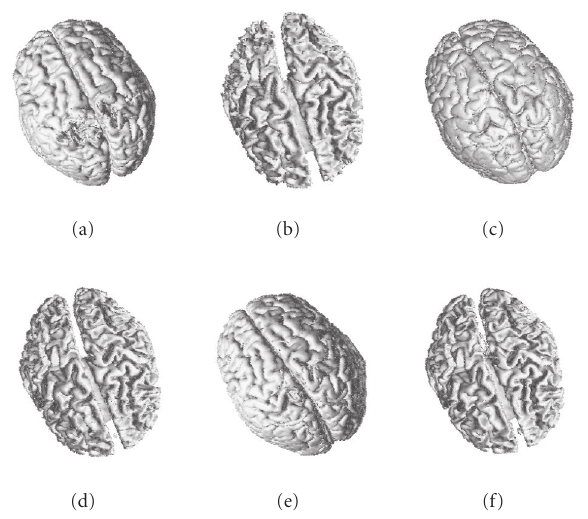
Figure 9: Comparison of the 3D models of GM and WM surfaces from our method and from the ground truth data. The test image is the same as in Figure 8. (a) and (b) are the 3D models of the GM and WM surfaces obtained from our method using morphological dilation; (c) and (d) are the 3D models of the GM and WM surfaces obtained from our method using histogram analysis; (e) and (f) are the 3D models of the GM and WM surfaces from the ground